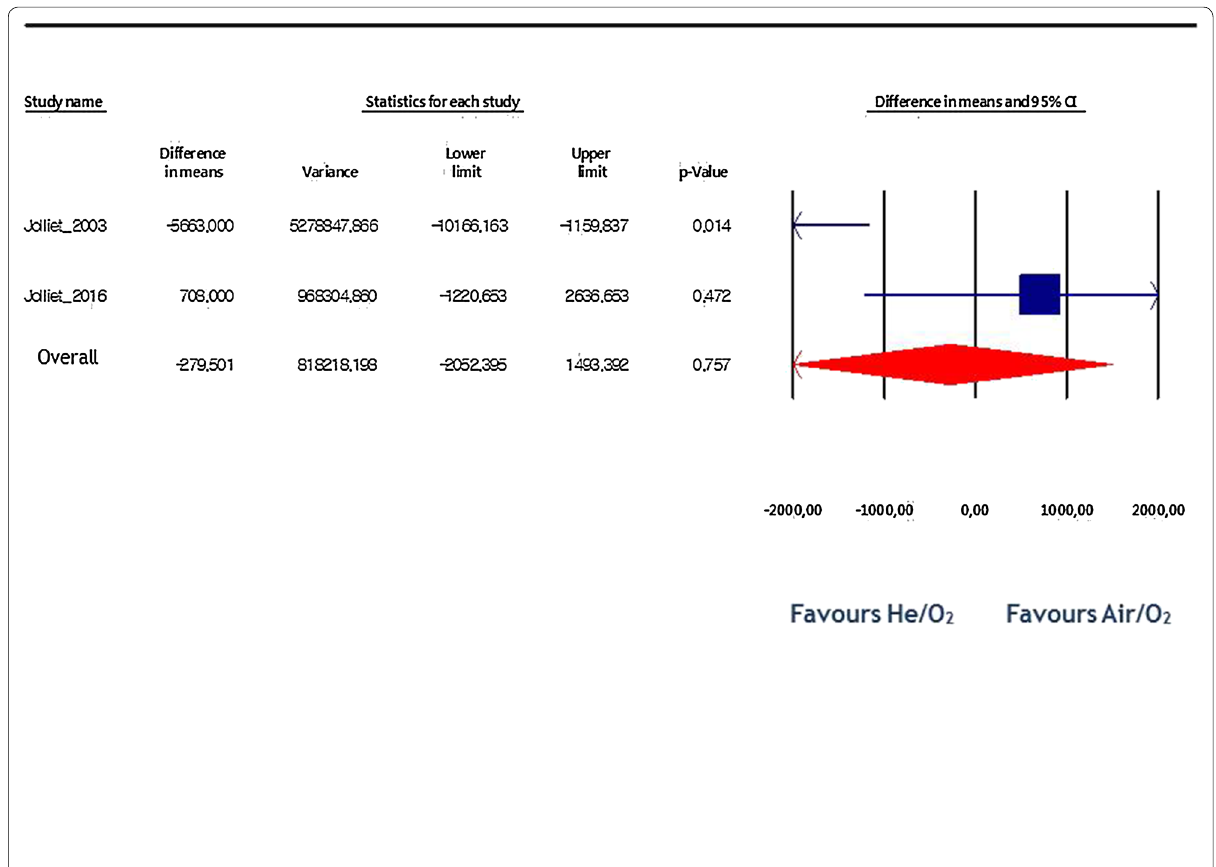
Fig. 6 Difference in total costs (per patient) of the initial admission. There was no statistical difference between study groups with a high heteroge‑ neity level between studies (I 2 :